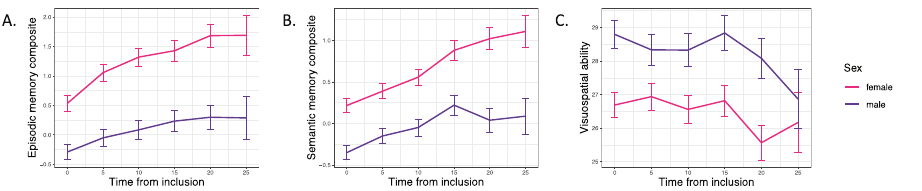
Fig. 1 Cognitive test performance for each cognitive domain across 25 years separately for males and females. A Episodic memory. B Semantic memory. C Visuospatial ability. Error bars show standard error.